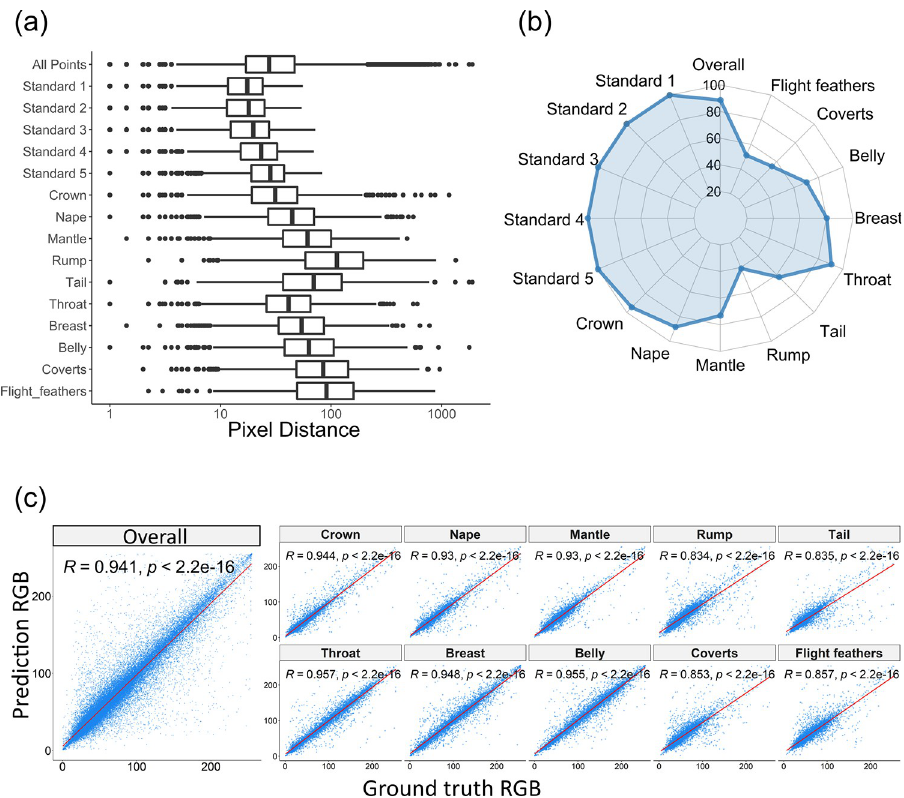
Fig 4. Evaluation results between ground truth and predictions for the avian specimen dataset. (a) Pixel distances. The x axis (pixel distance) is logarithmic scaled; (b) PCK-100; (c) RGB Colour correlations (colour extraction method: